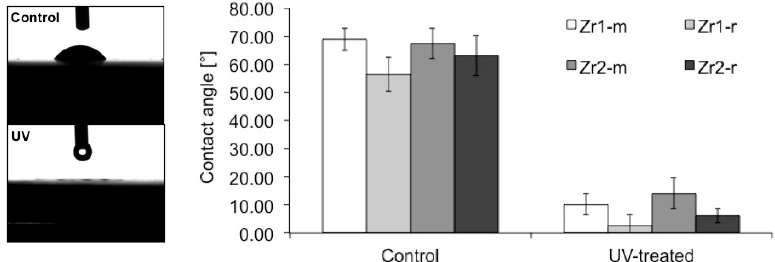
Figure 5. Alteration of the hydrophilic property of zirconia disks with smooth and roughened surfaces after UV treatment. A photographic image of 1- μ L H 2 O droplets pipetted onto zirconia disks before and after the application of UV light ( left ). The histograms show the contact angle of 1- μ L H 2 O droplets measured by an automatic contact angle measuring device before and after UV treatment on different zirconia disks with smooth and roughened surfaces ( right ).